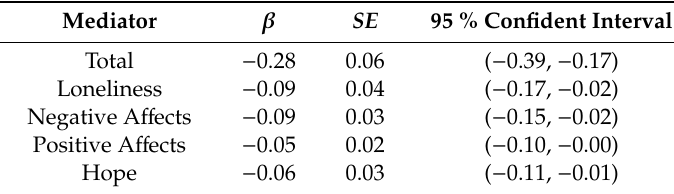
Table 2. Standardized coefficients and bootstrapping results of the mediation model.